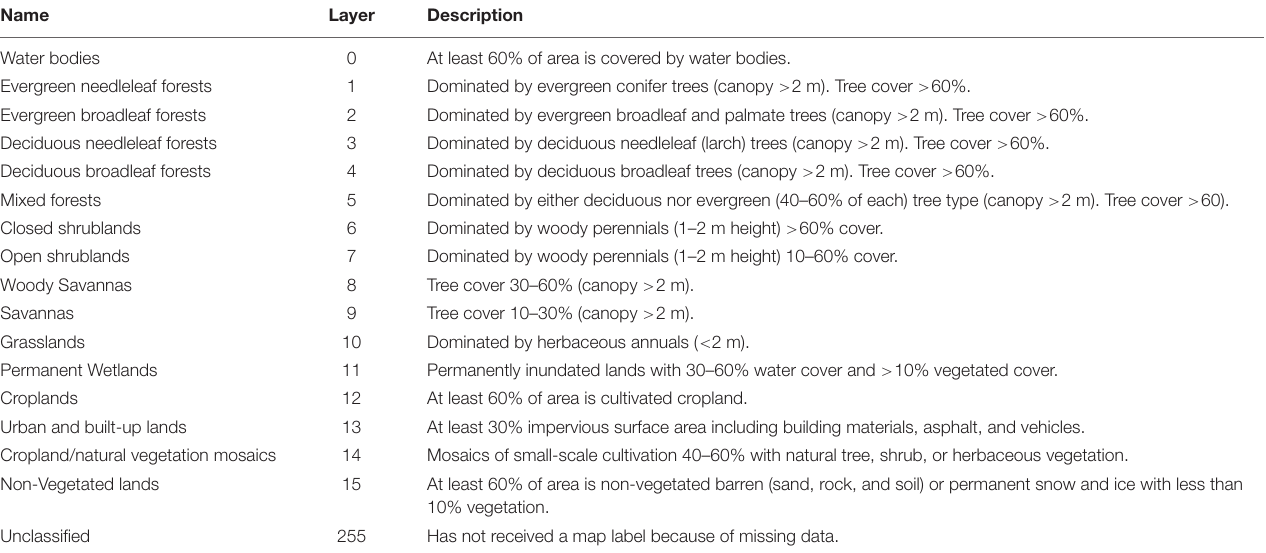
TABLE 3 | MODIS land cover classification layers and descriptions [adapted from Friedl and Sulla-Menashe, 2019]. Name Layer